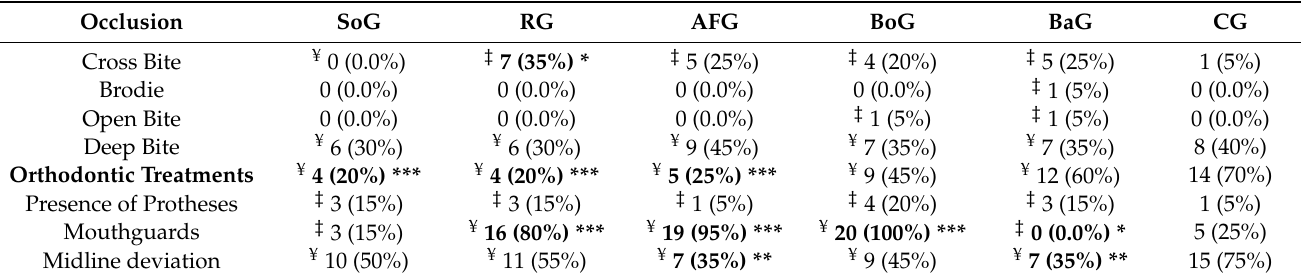
Table 3. Occlusion: comparison between different sports and controls.